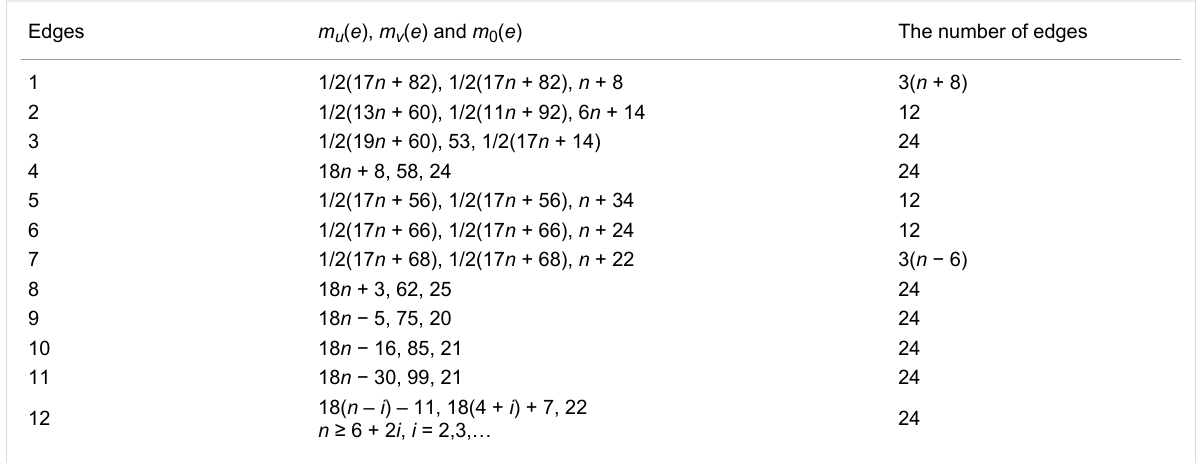
Table 4: m u ( e ), m v ( e ) and m 0 ( e ) for different types of edges, n is even and n ≥ 8.